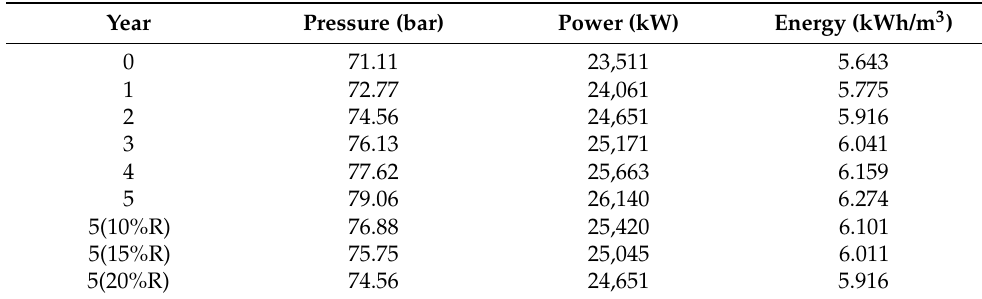
Table 2. Pressure, Power and Energy consumption at 17 ◦ C.